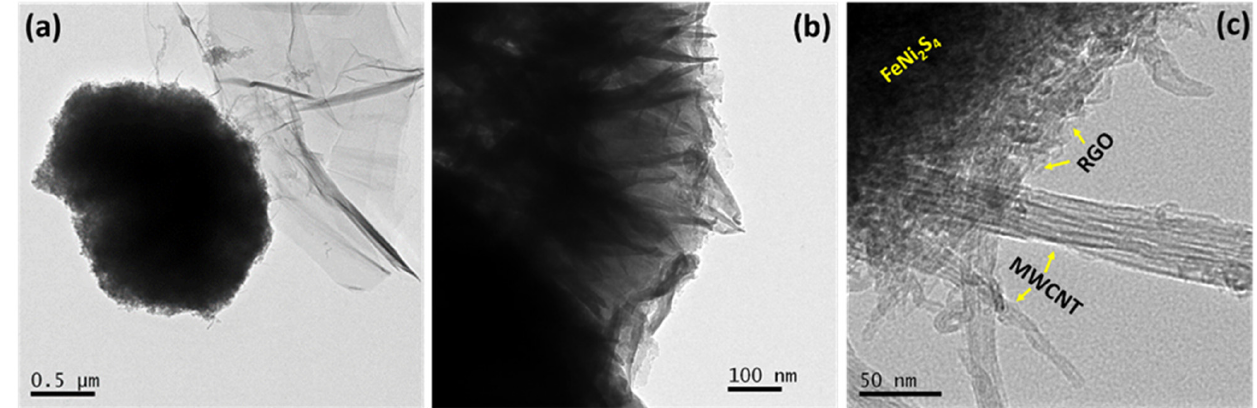
Figure 3. ( a ) TEM for FNS@GC composite, ( b ) magnified version of TEM image, and ( c ) further magnified image showing the integral presence of MWCNTs and rGO with FeNi 2 S 4 particle.